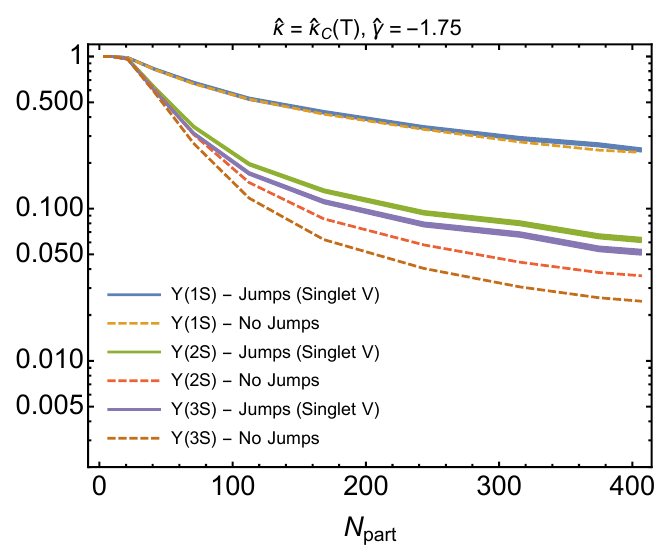
Figure 8 . Singlet S -wave survival probabilities versus N part obtained when replacing in the code the repulsive color octet potential with an attractive color singlet potential. Dashed lines show the results obtained with no quantum jumps, i.e. when the evolution is entirely described by H eff . The full QTraj results are represented by continuous lines (the bands account for the statistical errors).